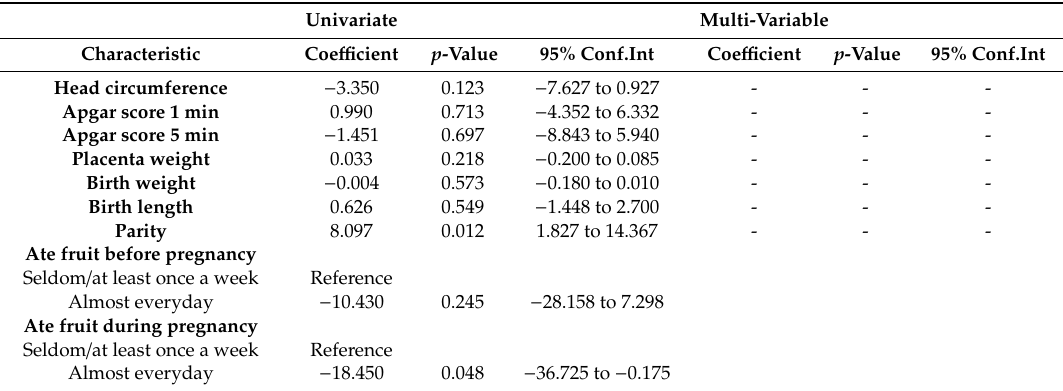
Table 8. Coe ffi cient estimates of quantile regression at 50% quantile-univariate and multi-variable regression for female neonates.